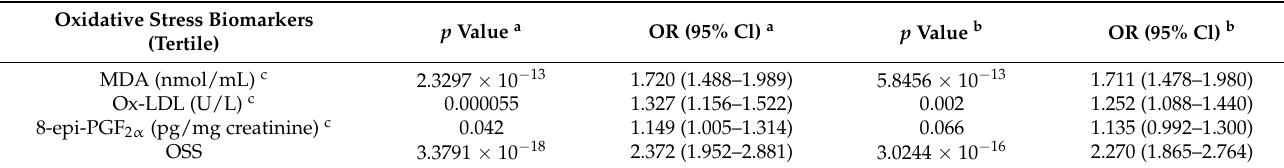
Table 3. Associations of oxidative stress biomarkers with prediabetes and T2DM in a Korean population. Oxidative Stress Biomarkers (Tertile)